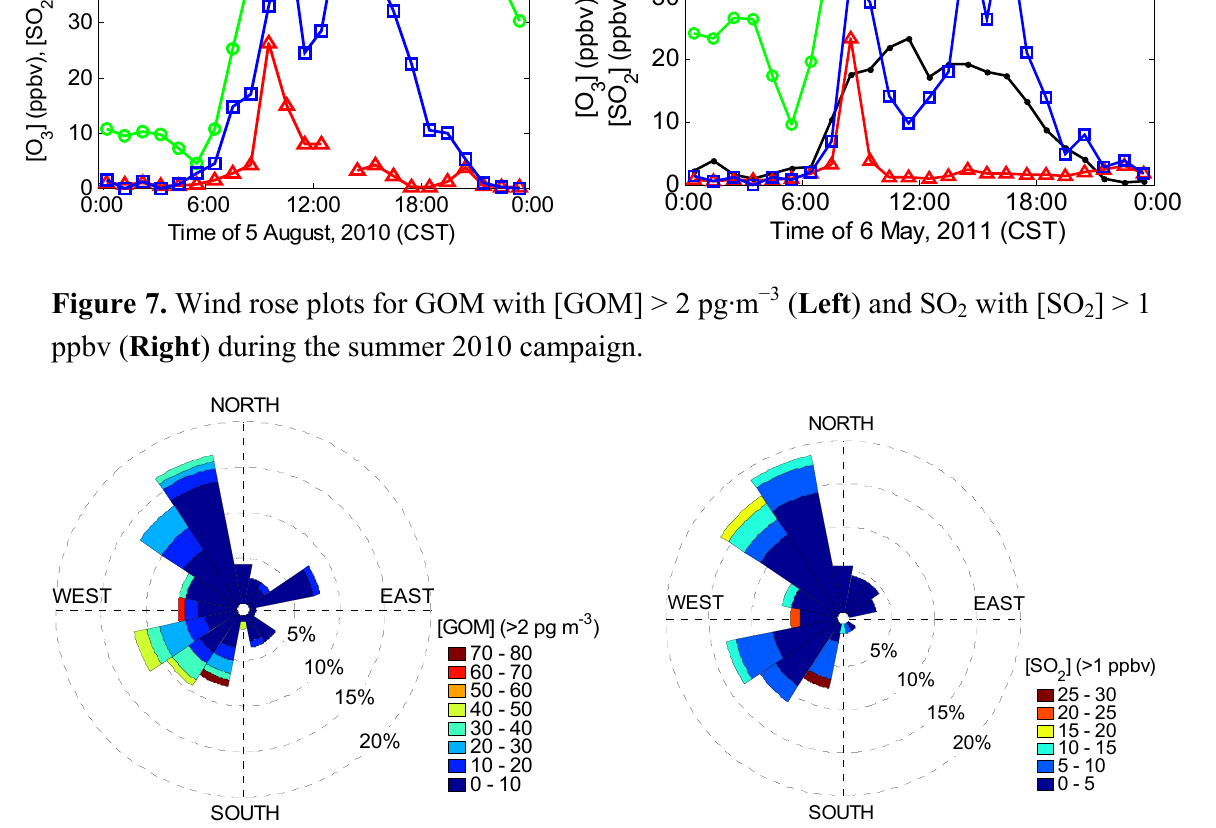
Figure 6. Diurnal variations of ozone, SO and 5 May 2011 ( Right ).